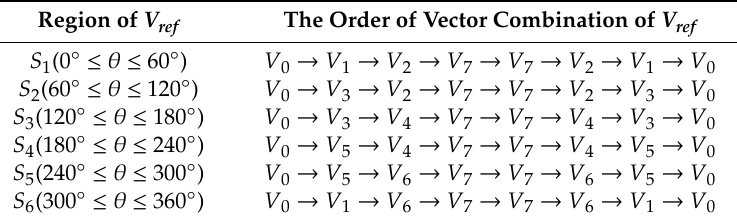
Table 1. Order of vector combination of ref V in each region.